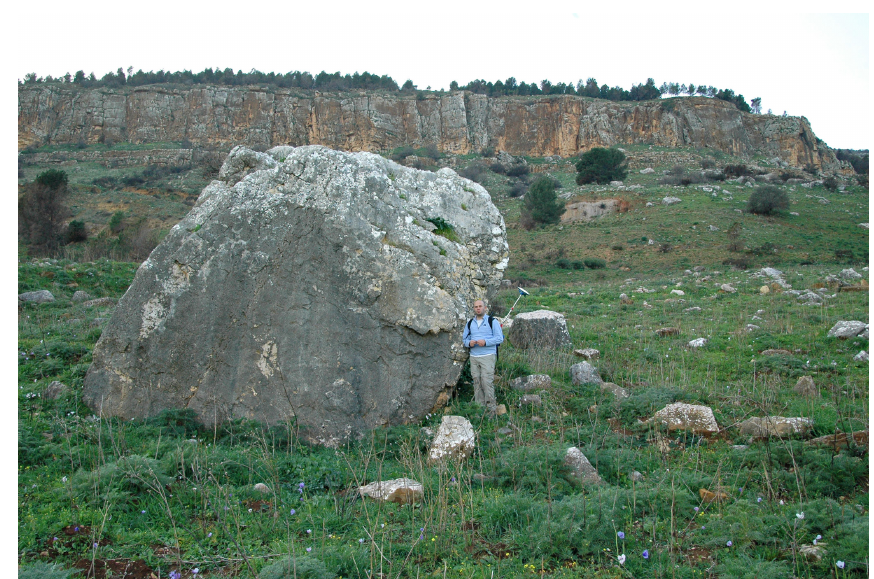
Figure 2. The source for rockfalls, the cliff of the Ein El Assad Formation, at the back and a rock block at its stop site. This large boulder, ∼ 41m 3 , is block no. 016 (Table 3), under which sample QS-11 for OSL age determination was excavated. Photo taken from east to west showing the source of rockfall in the background. The location of the block in the photo is plotted as a yellow rectangle in Fig.